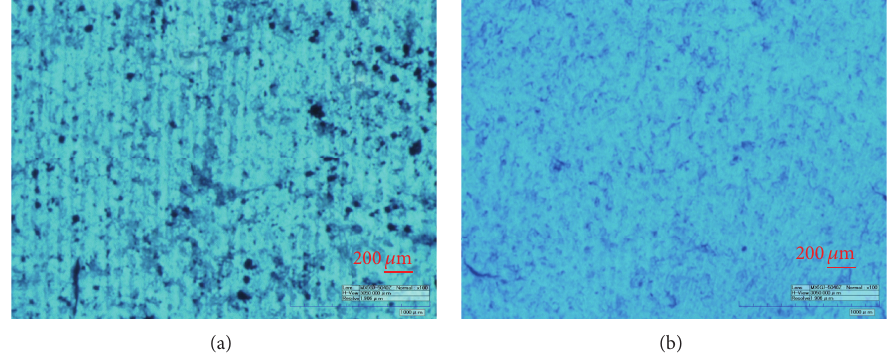
Figure 4: Typical 3D-POM images of the film made from the blended latex of P(BA+St)-PB (a) and the film made from the nanocomposite latex of the P(BA+St)/PB (b) at a transmission mode.